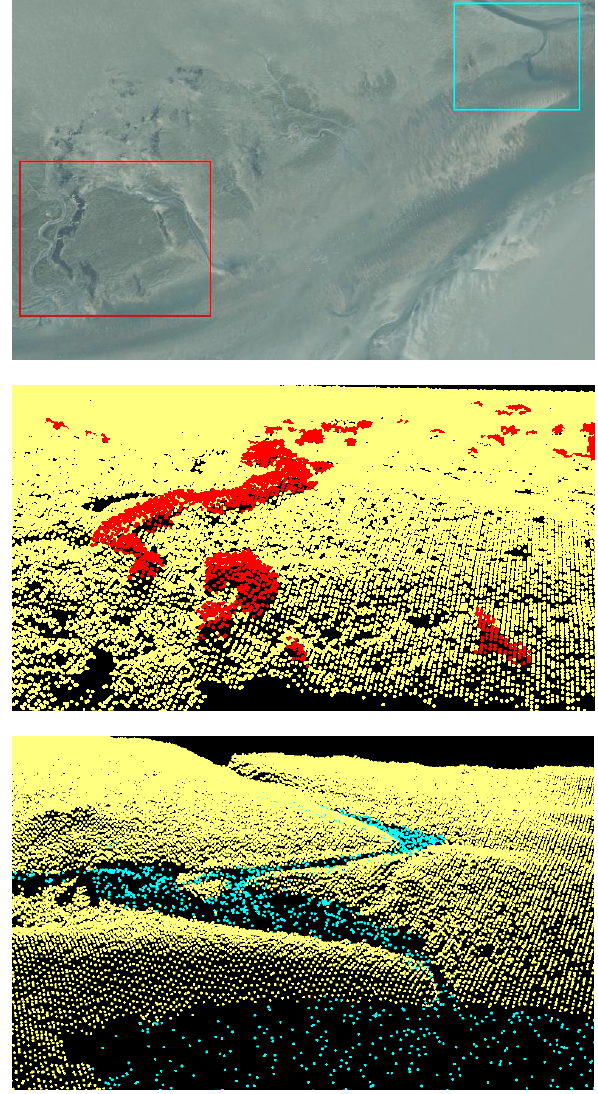
Figure 1: Orthophoto and labelled point cloud with the classes water (blue), mussel bed (red), and mudflat (yellow), illustrated with an increased vertical exaggeration of the factor ten feature vector as well as on those obtained for all points in the defined neighbourhood . The posterior